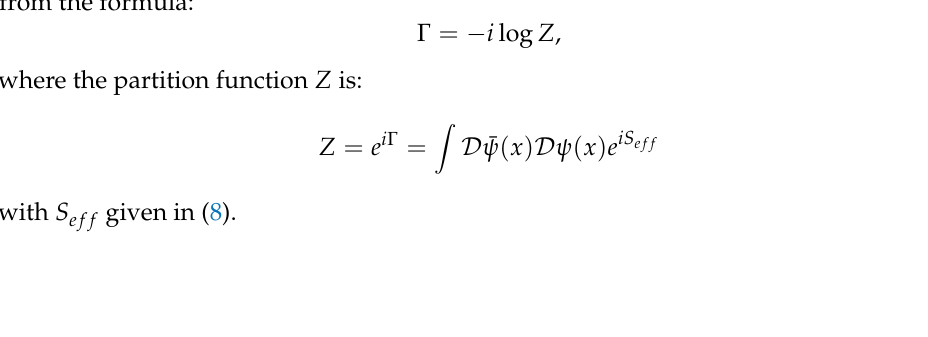
√ √ eB = 0.4 and ( b ) eB =